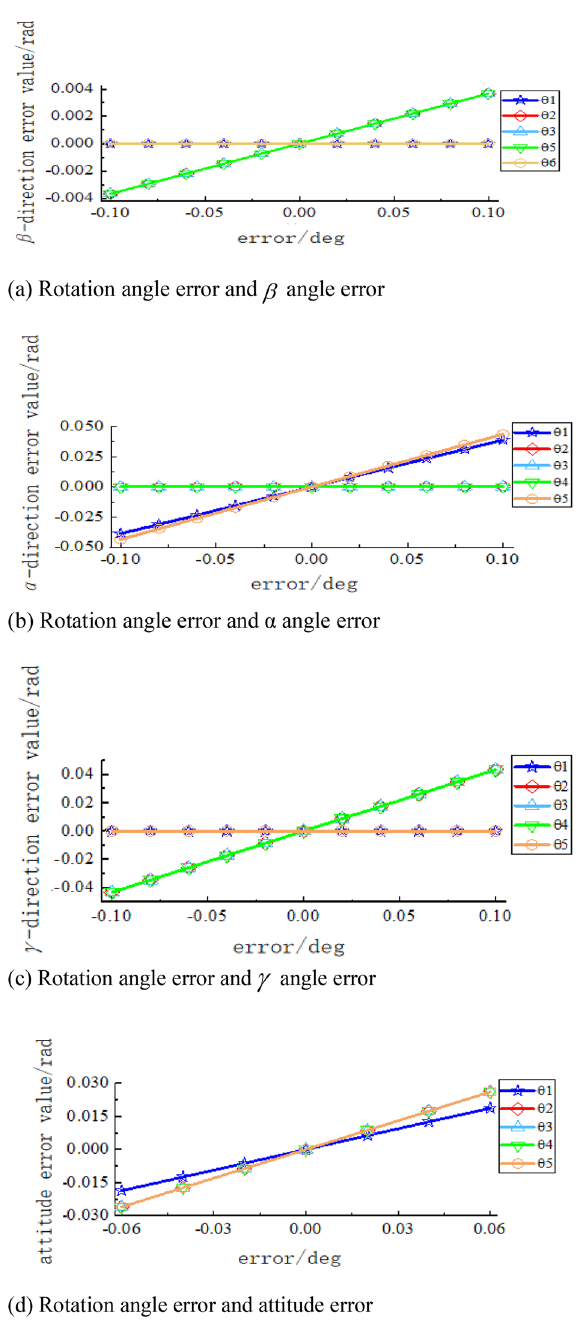
Figure 9. Sensitivity curve of rotation angle error to terminal attitude error. ( a ) Rotation angle error and β angle error, ( b ) Rotation angle error and α angle error, ( c ) Rotation angle error and γ angle error, ( d ) Rotation angle error and attitude